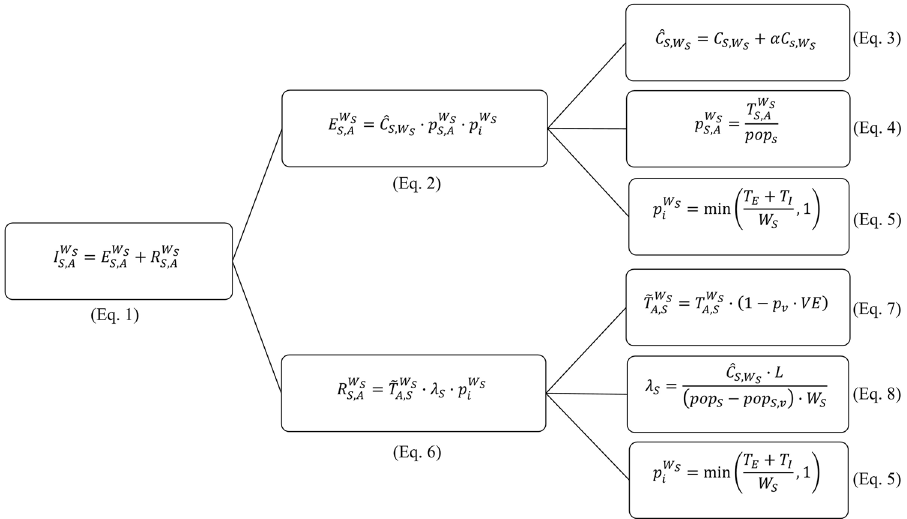
Figure 3. Branching tree illustrating the hierarchical nature of our risk model. The total number of AW importations ( I , left) is the sum of importations caused by incoming Brazilian travelers ( E S , S importations caused by US and international travelers ( R further broken down into three model terms